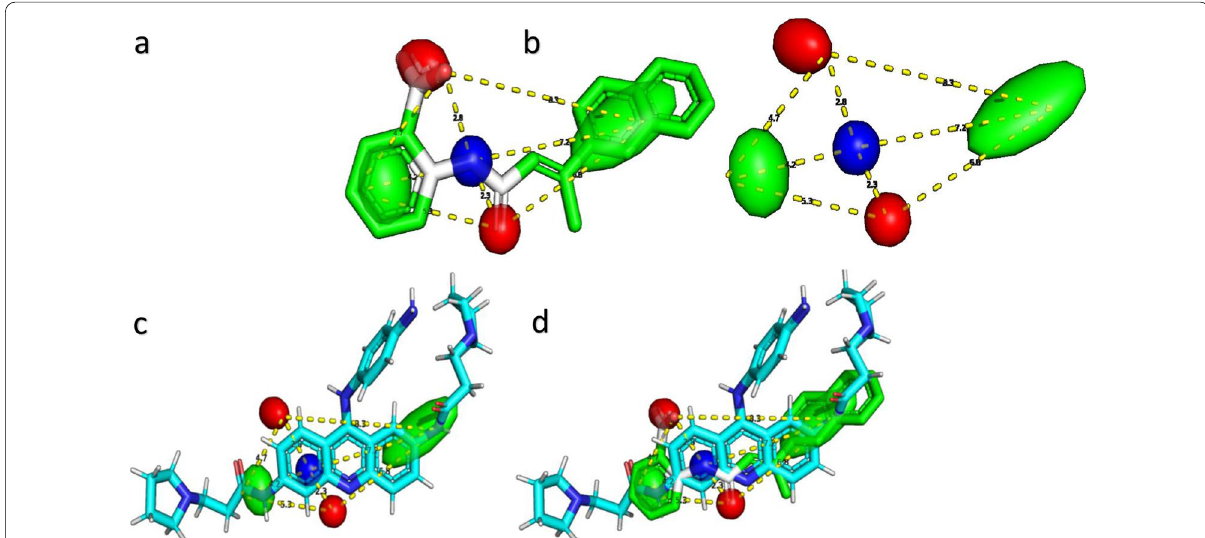
Fig. 12 a Pharmacophore model with co-crysallized ligand (pdb-5cqg), b different regions with distances only, c pharmacophore model for Most active compound 82, d pharmcophore model with align pdb(5cqg) crystallized ligand and most active compound 82 with